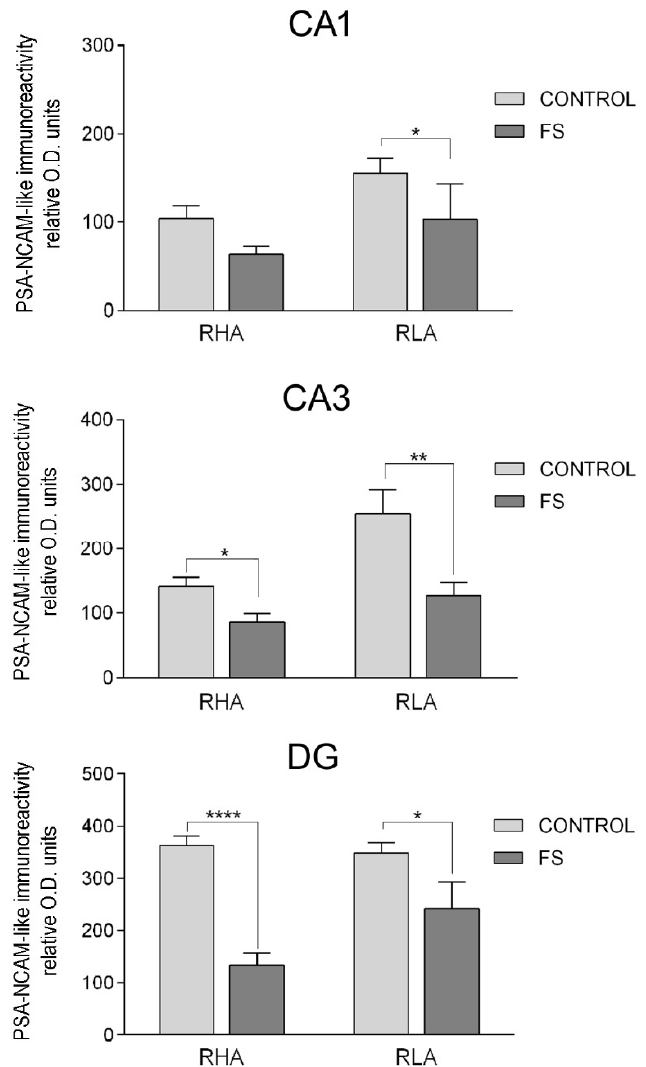
Figure 9. Densitometric analysis of the PSA-NCAM-like immunoreactivity in the CA1 and CA3 sectors of the Ammon’s horn and in the dentate gyrus (DG) of the ventral hippocampus, in baseline conditions (CONTROL) and after forced swimming (FS). Columns and bars denote the mean ± S.E.M. of six rats, in each experimental group. Two different sections were analyzed for each rat. *: p < 0.05; ** p < 0.01; ****: p < 0.0001 (Tukey’s post hoc test or Sidak’s correction for multiple comparisons).